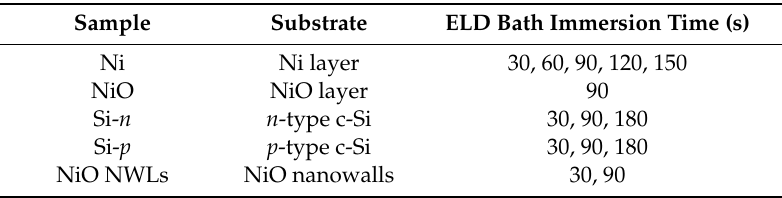
Table 1. Summary of prepared samples.